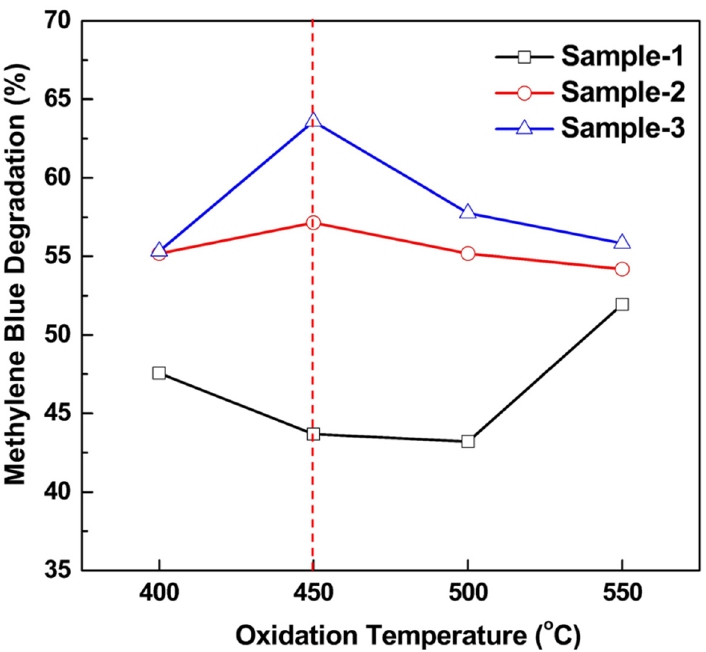
Figure 11. Photocatalytic activity of TiO 2 thin-film samples at different oxidation temperatures irradiated at 180 min.